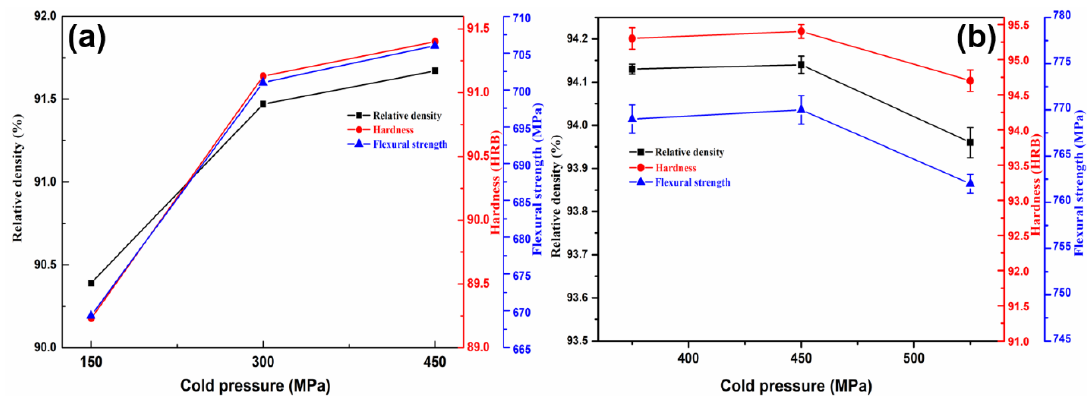
Figure 3. The effect of cold pressure on the mechanical properties of the samples (( a ) Orthogonal experimental; and ( b ) Conditional experiment (880 °C, 35 min)).